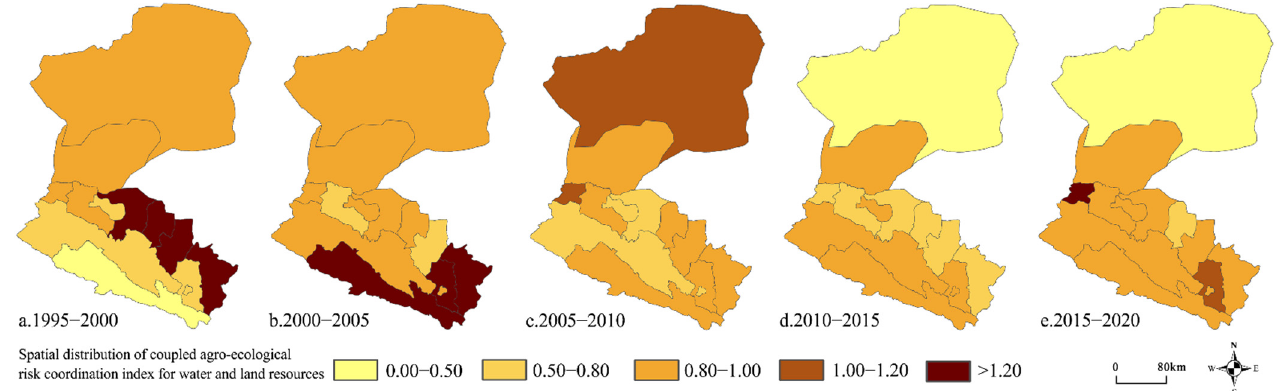
Figure 4. Spatial distribution of coupled agroecological risk coordination index for WLR in the